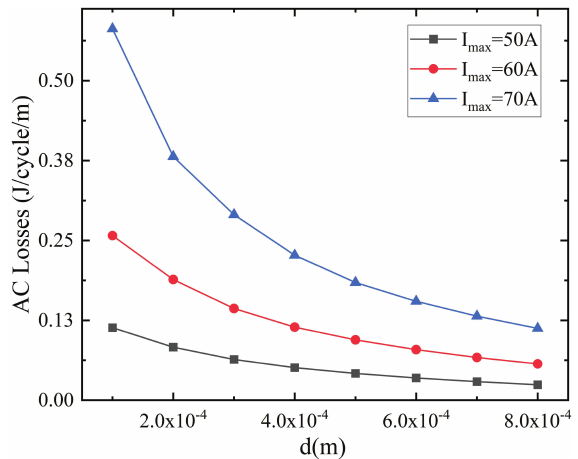
Figure 11. Losses at different in sulating layer